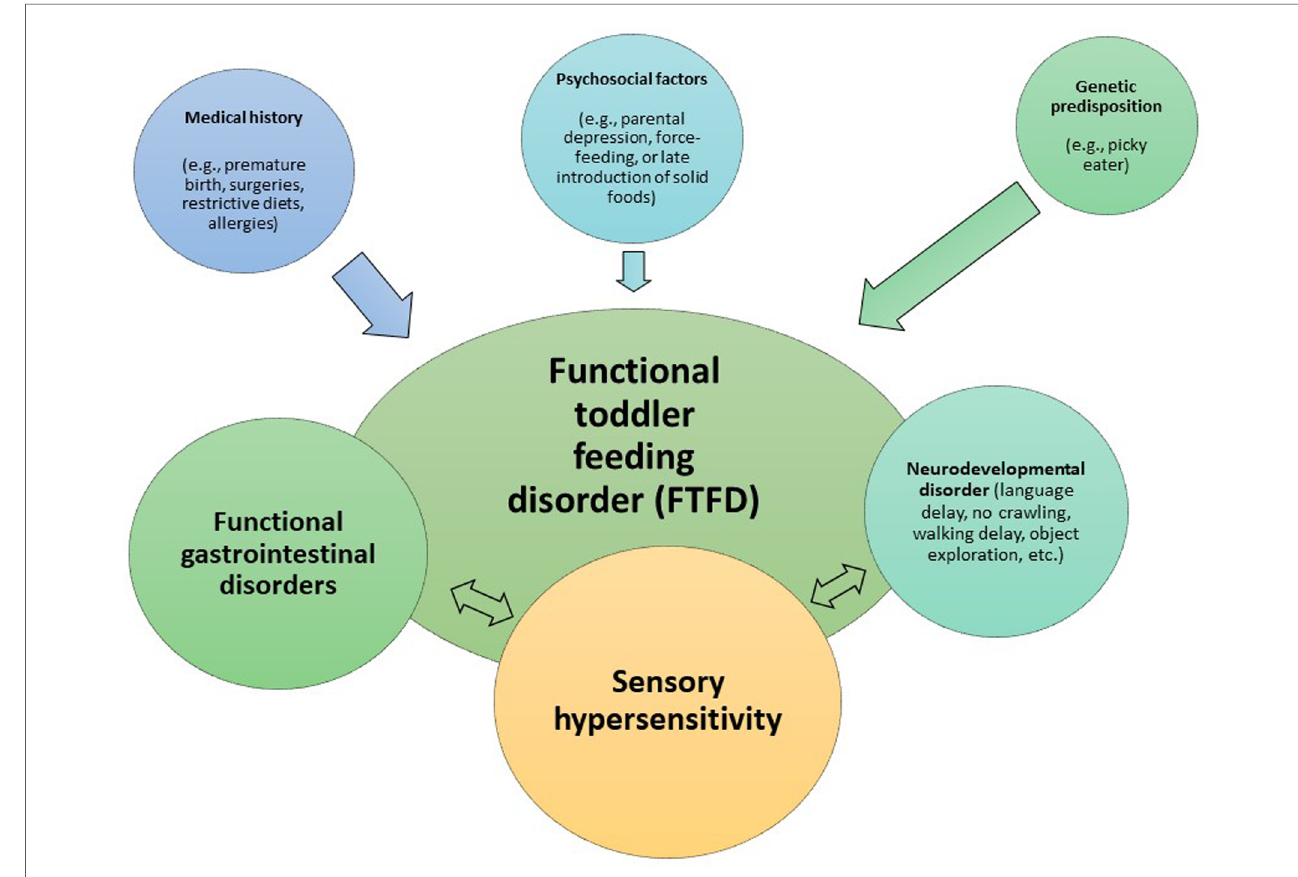
FIGURE 2 Biopsychosocial model of functional toddler feeding